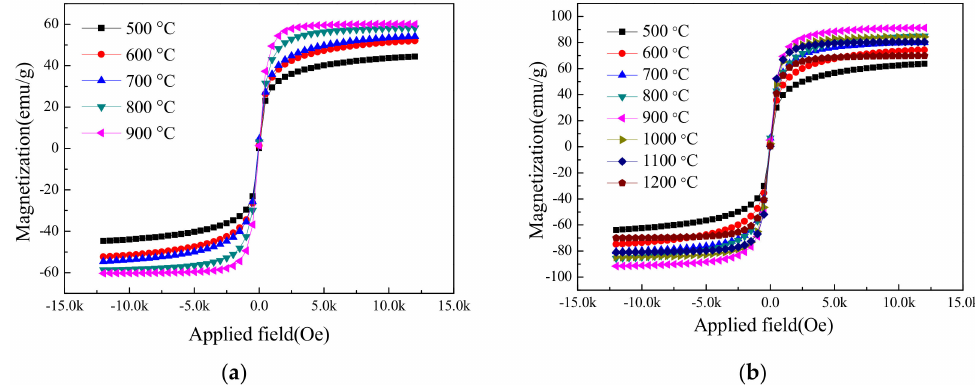
Figure 5. The effect of sintering temperature on the magnetism. ( a ) Cu 0.7 Zn 0.3 Fe 2 O 4 ; ( b ) Ni 0.5 Zn 0.5 Fe 2 O 4